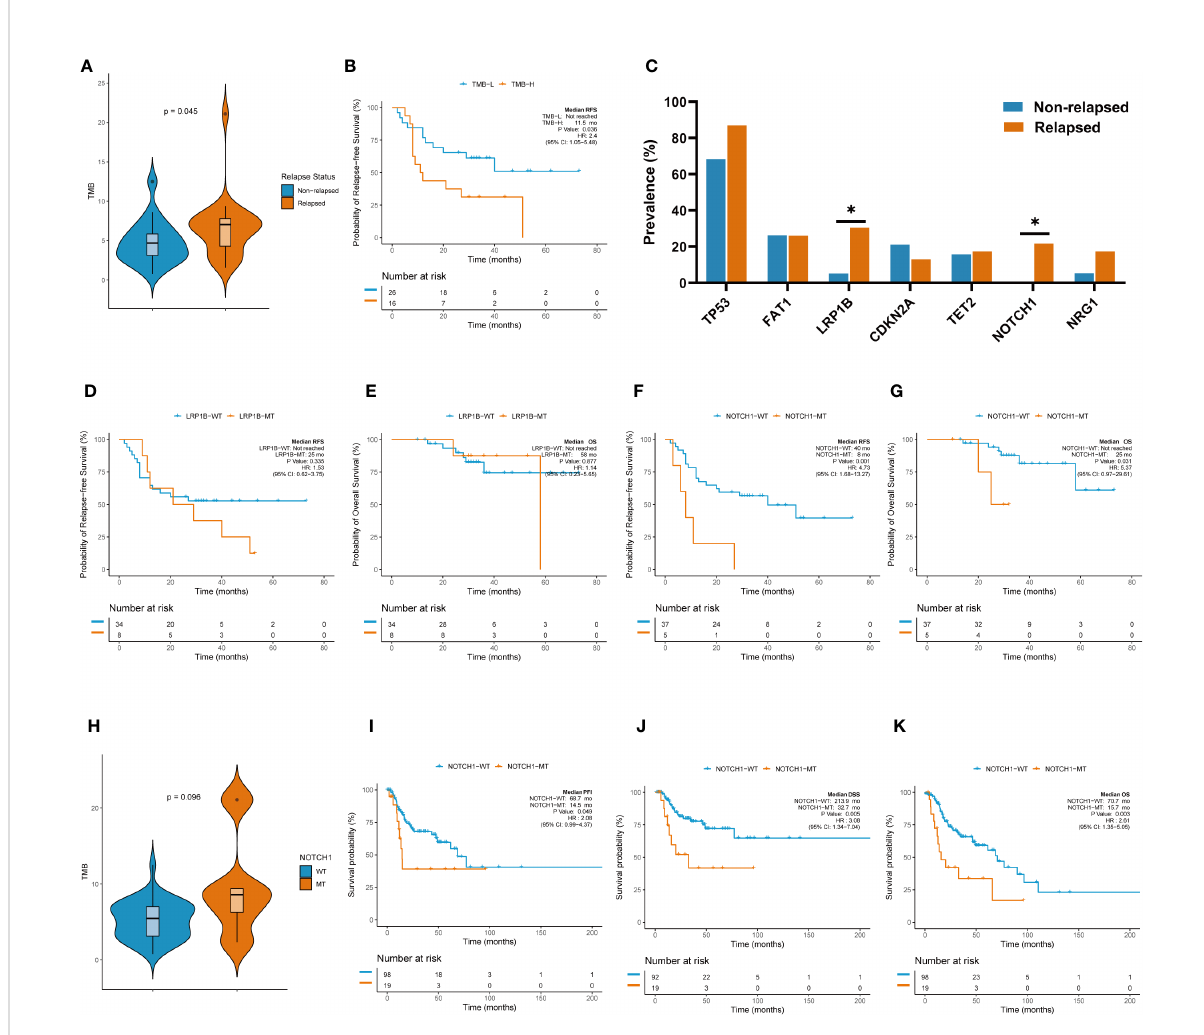
FIGURE 4 TMB and individual gene mutations were associated with clinicalsurvival outcomes. (A) TMB values in the relapsed group and the non-relapsed group. (B) Higher TMB (top 25%) was associated with poorer RFS outcomes. (C) Rate of individual somatic mutated genes between the two groups. (D) K-M survival curve on LRB1P mutation with RFS. (E) K-M survival curve on LRB1P mutation with OS. (F) K-M survival curve on NOTCH1 mutation with RFS. (G) K-M survival curve on NOTCH1 mutation with OS. (H) TMB values in the NOTCH1 mutation group and wild-type group. (I) K-M survival curve on NOTCH1 mutation with PFI in TCGA. (J) K-M survival curve on NOTCH1 mutation with DSS in TCGA. (K) K-M survival curve on NOTCH1 mutation with OS in